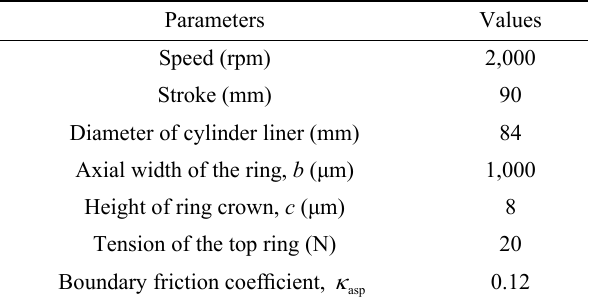
Table 2 Engine data.